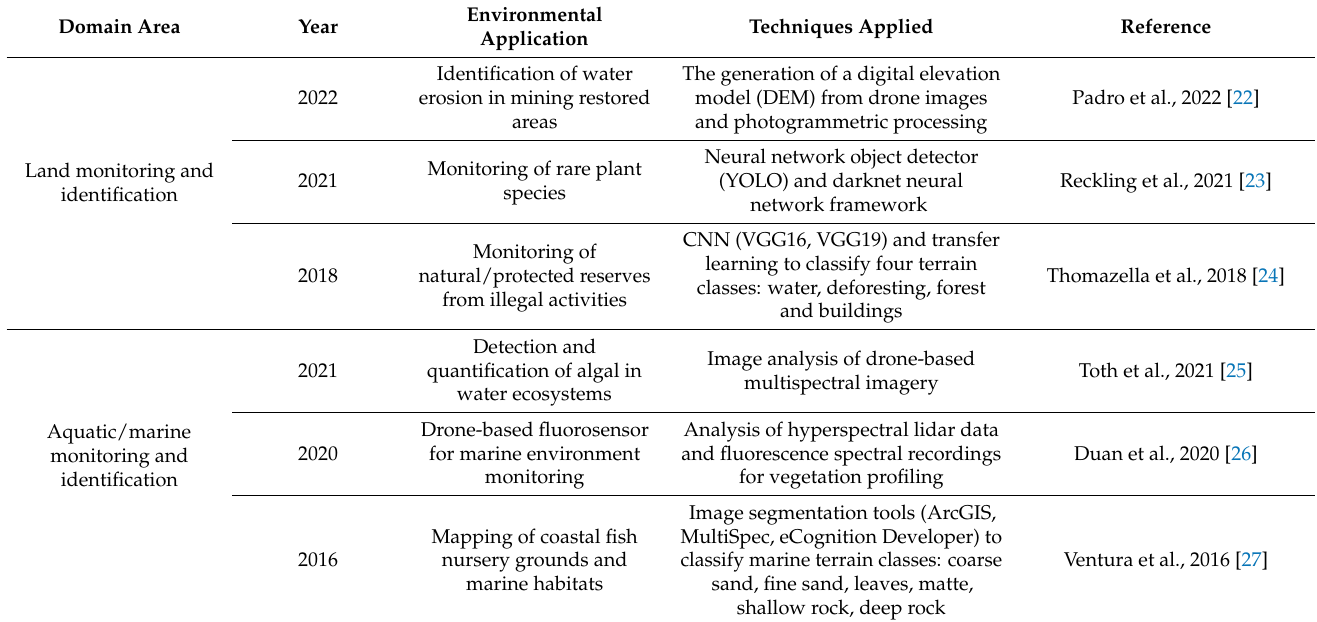
Table 1. Some recent works on drone-based approaches for environmental